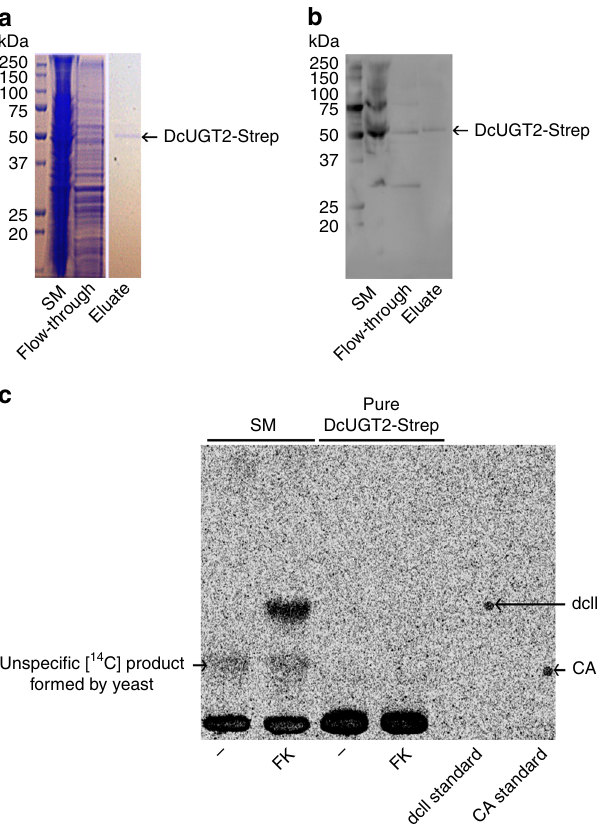
Fig. 6 DcUGT2-Strep loses enzyme activity upon af fi nity puri fi cation. Yeast microsomes containing DcUGT2-Strep were solubilized with reduced Triton X-100 and DcUGT2 af fi nity puri fi ed by its Strep-tag II. Protein fractions were tested for glucosylation activity by incubation with [ 14 C] UDP-glucose and with/without fl avokermesic acid. a Protein samples separated on an SDS gel followed by Coomassie staining. b Protein samples separated on an SDS gel followed by western blotting using an anti-Strep antibody. c TLC-separated [ 14 C] products formed in vitro and viewed by phosphorimaging. SM solubilized microsomes; fl ow-through proteins that did not bind to the af fi nity matrix; eluate protein fraction C1 (Supplementary Fig. 3) which was eluted from the af fi nity matrix with desthiobiotin. FK fl avokermesic acid, CA carminic acid. Note that the anti-Strep antibody